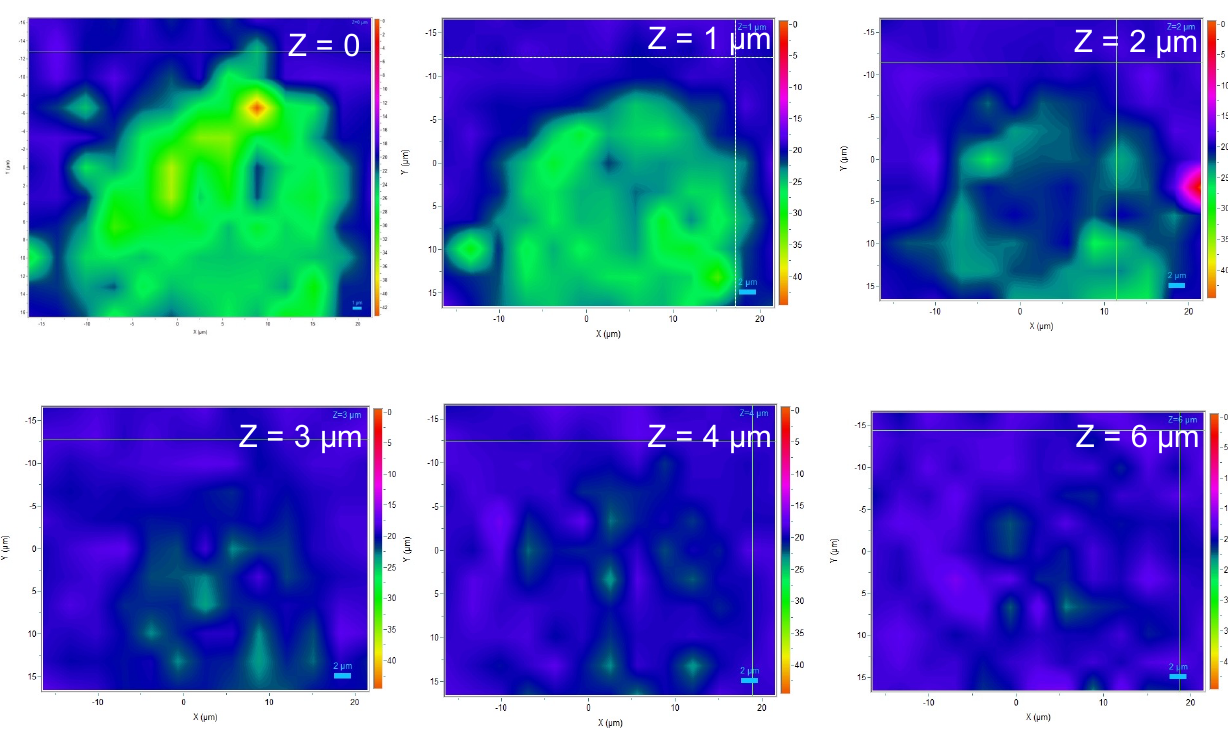
Figure 7. Raman cartography of a typical defect (each map refers to a particular depth, Z).